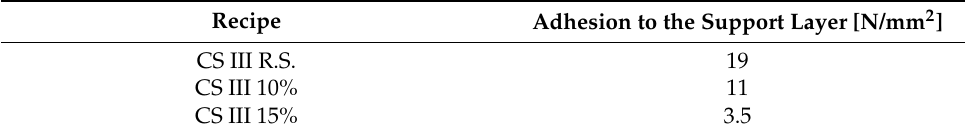
Table 9. Results for adhesion to the support layer on hardened mortars.